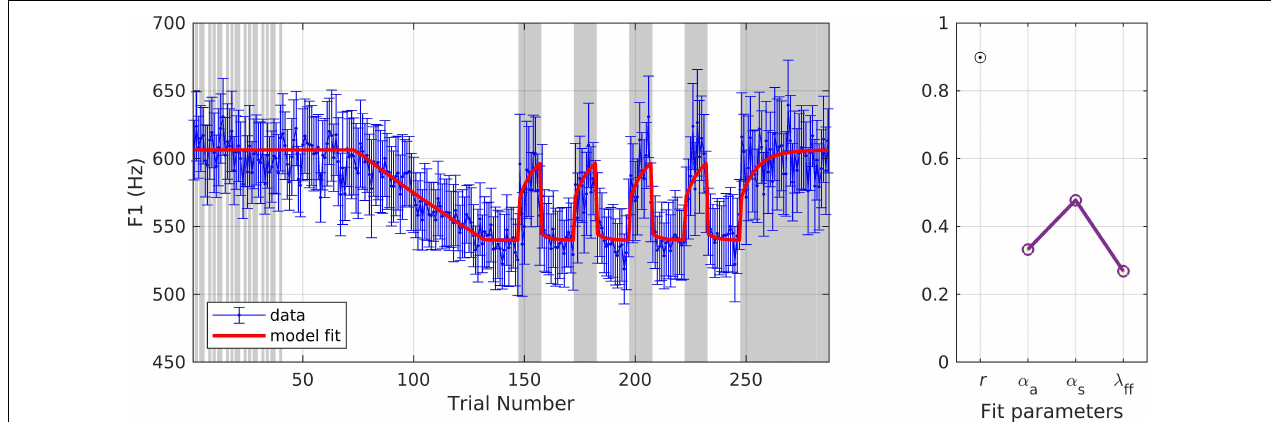
FIGURE 4 | Simulation 2: model fits of a dataset with upward perturbations in F1 and noise-masked trials (indicated with gray shading) interspersed during baseline and hold phases (data from Ballard et al., 2018). (Left) Mean and standard error of experimental data in blue; model fit in red. (Right) Fit quality and optimized parameter values ( r = correlation coefficient; α A = auditory feedback control gain, α s = somatosensory feedback control gain, and λ FF = learning